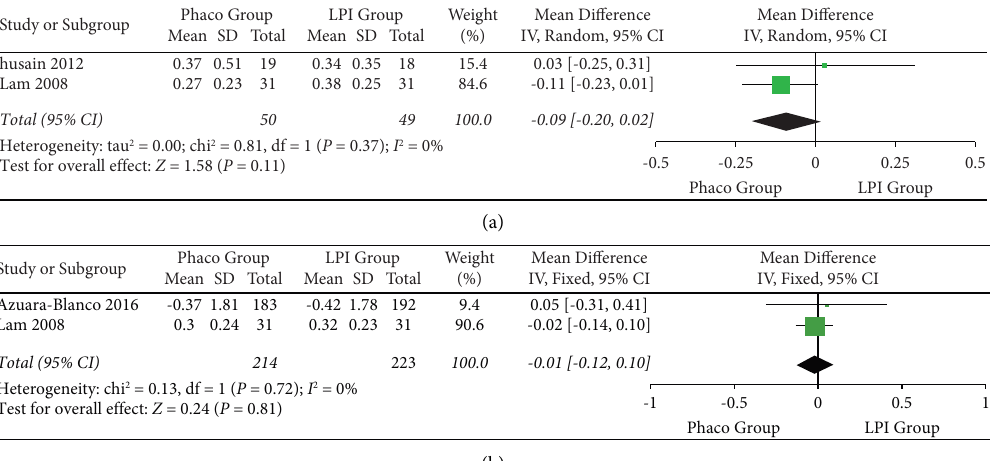
Figure 7: Forest plots comparing the BCVA between the Phaco groups and LPI groups at diferent follow-up times. (a) Six months after the operation. (b) Twelve months after the